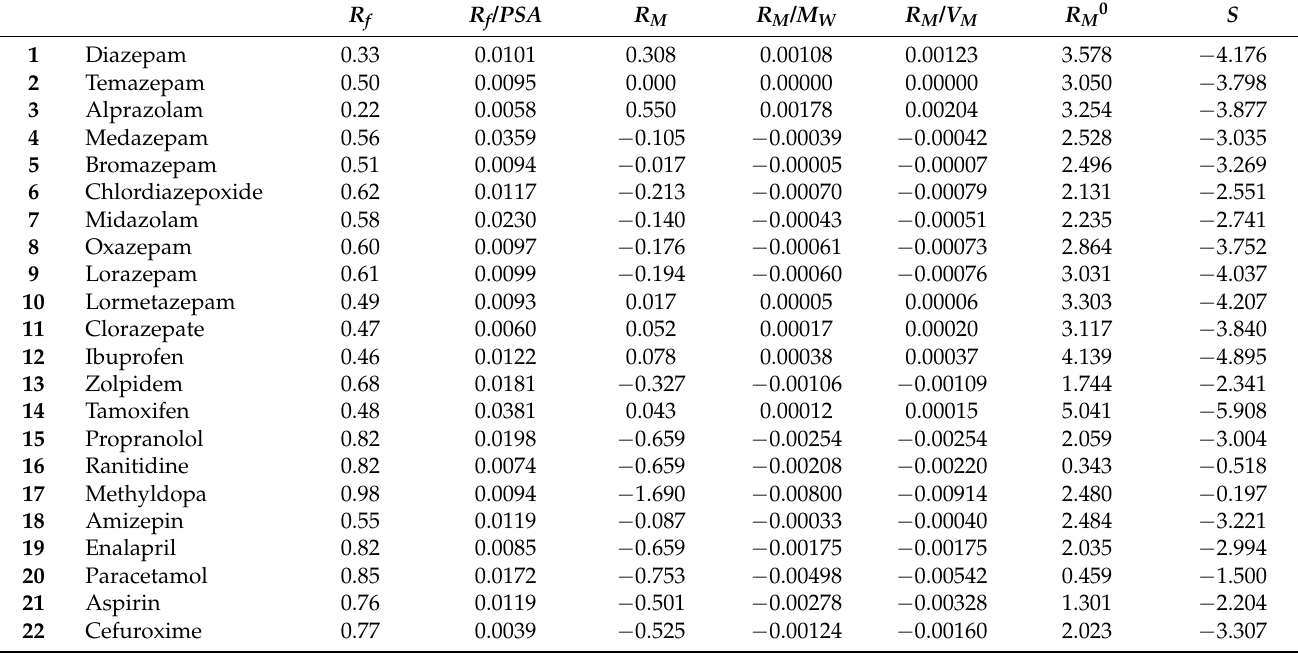
Table 4. Chromatographic parameters for compounds 1 to 63